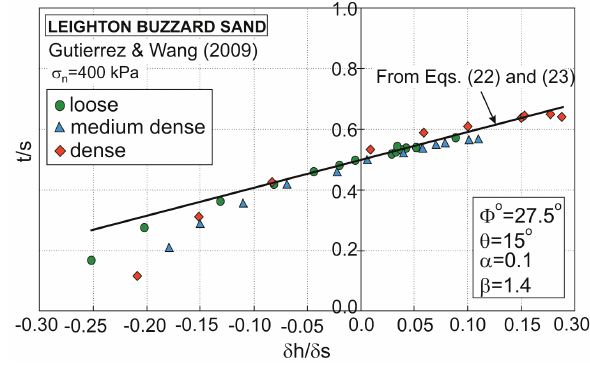
Fig. 6. Stress ratio-dilatancy relationship for Leighton Buzzard sand